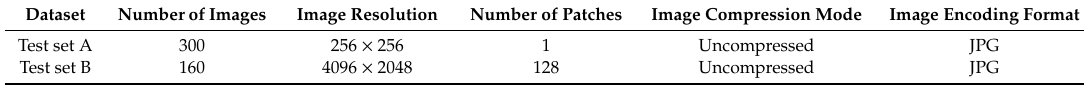
Table 1. Description of test sets used in experimental evaluation of our proposed